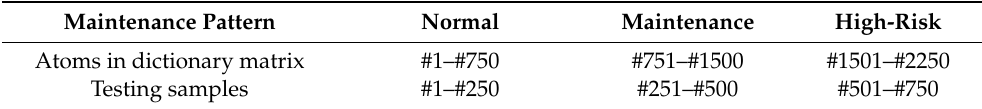
Table 2. Details of dictionary matrix and testing samples.